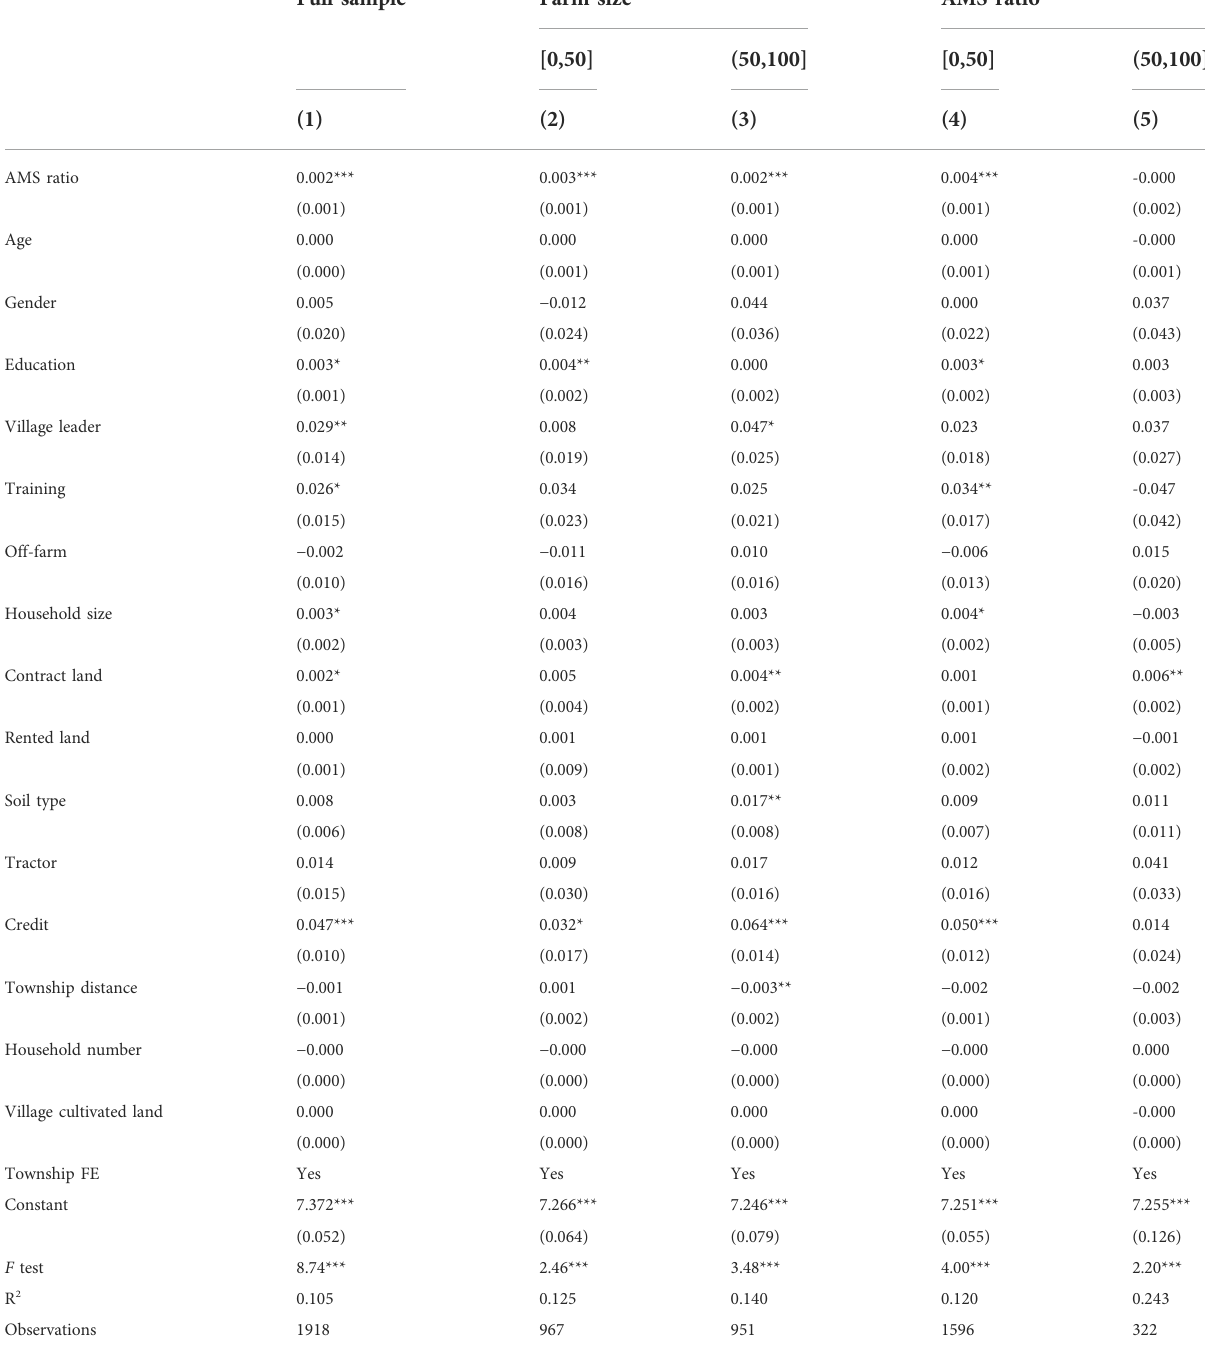
TABLE 2 OLS regression for the effect of AMS on cultivated land